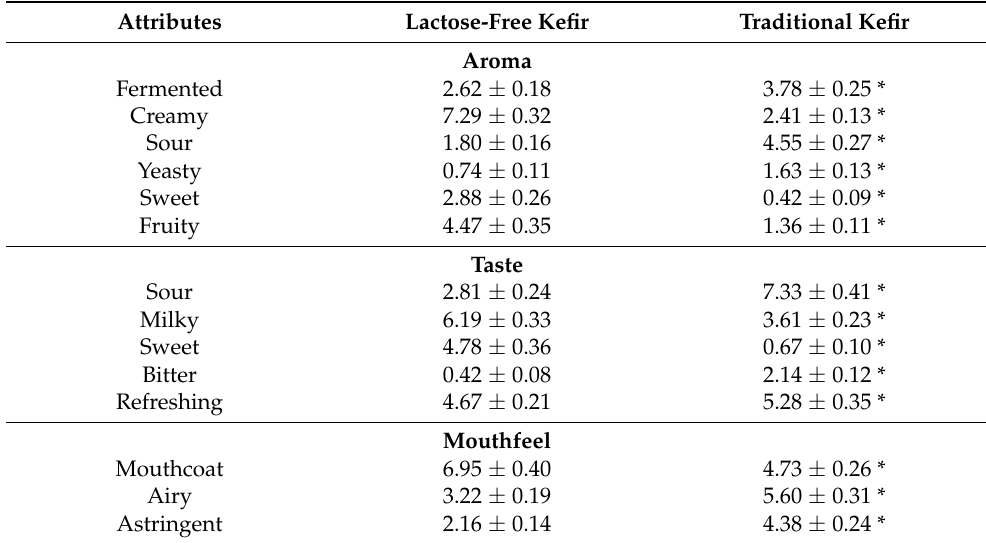
Table 3. Mean values ( ± SD) of the intensities of aroma, taste and mouthfeel attributes of kefir assayed by trained panel (n = 10) (no intensity—0; very high